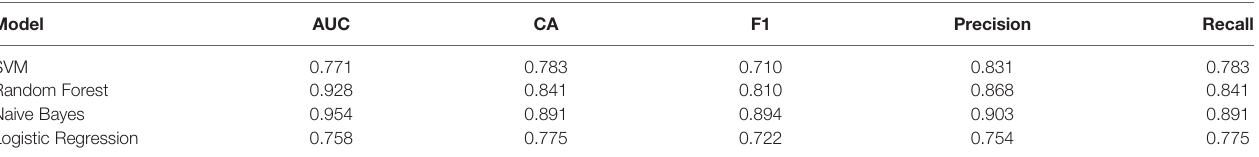
TABLE 3 | Classi fi er model